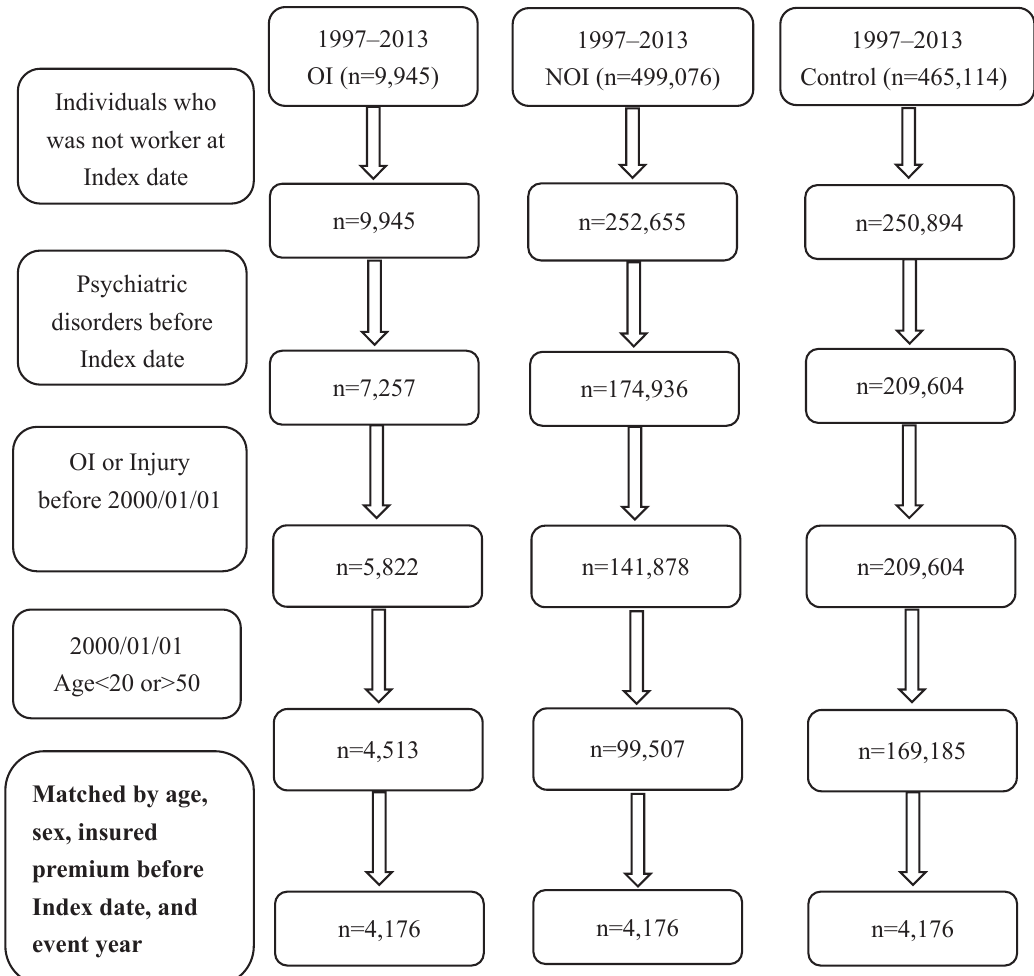
Figure 1. Flow chart showing the procedures of including patients in di ff erent study cohorts for fi nal